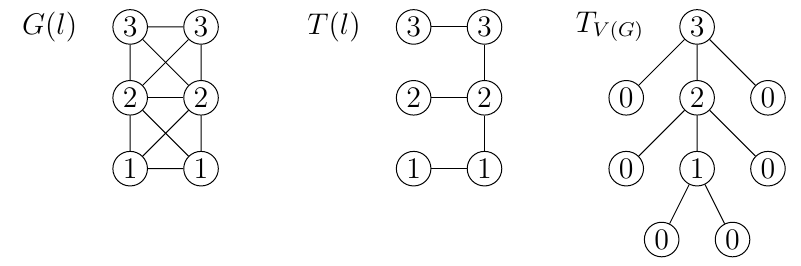
Figure 6: Here T = T ( l ) is a spanning tree for G ( l ) satisfying the equality ρ is the representing tree for the ultrametric space ( V ( G ) , ρ